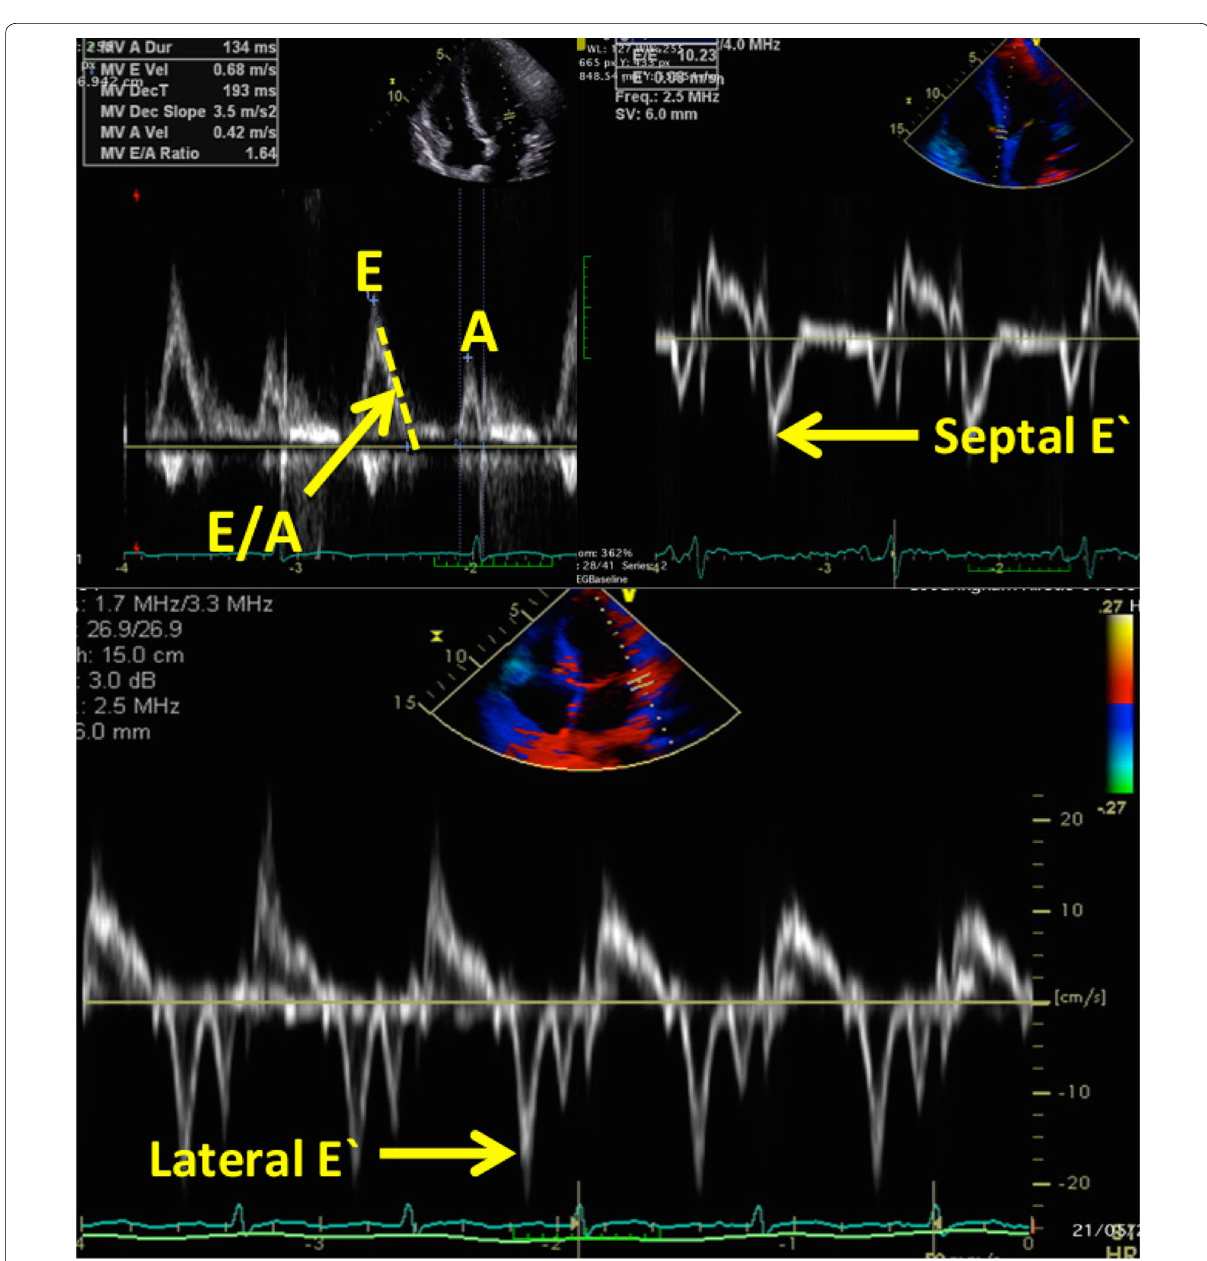
Fig. 3 Examples of Doppler assessments used for assessment of left ventricular diastolic function (trans-mitral inflow and tissue Doppler assess- ment of the septal and lateral mitral valve annulus). A , late diastolic trans-mitral flow velocity wave, E early diastolic trans-mitral flow velocity wave, E ′ , early diastolic mitral annulus